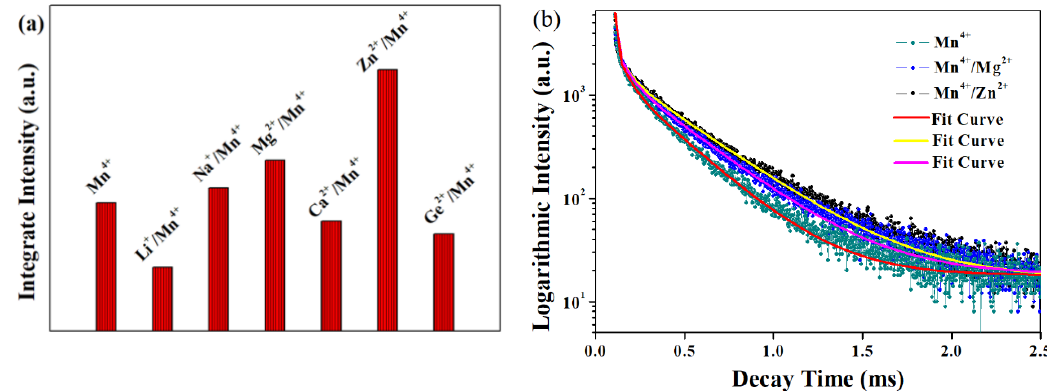
Figure 9. ( a ) Integrated intensity for the Mn 4+ (0.01 mole)/LMA and Mn 4+ /M/LMA (M = Li + , Na + , Mg 2+ ,